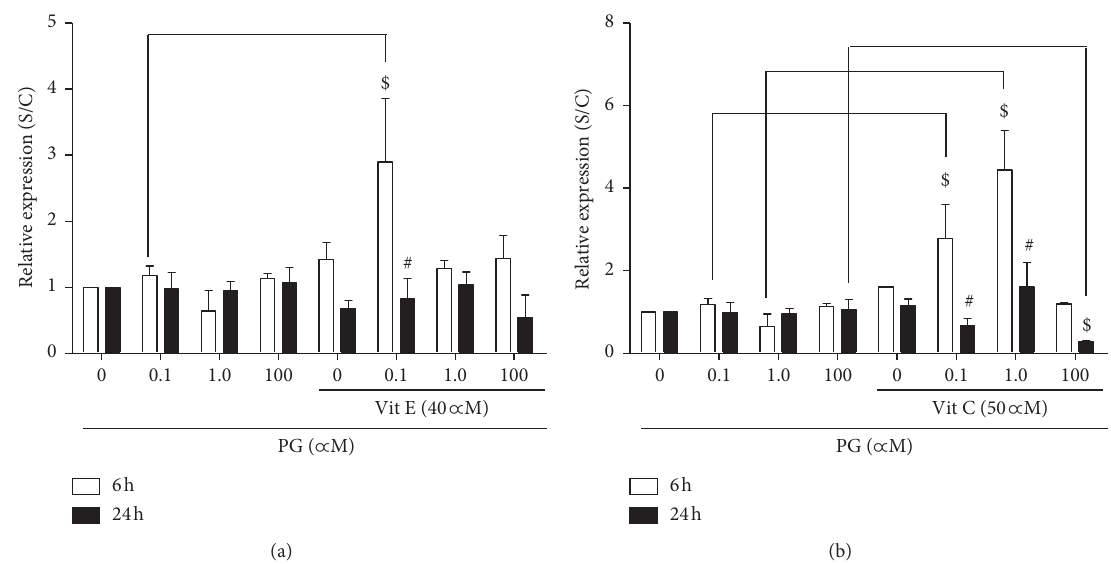
Figure 6: Expression of Prdx4 in progesterone-treated RINm5Fcells, in the presence of antioxidants. After preincubation with 40 μ M vitamin E (a) or 50 μ M vitamin C (b) for 2h, cells were incubated, for 6 or 24 h, with 0.1, 1.0, or 100 μ M progesterone. Data are presented as means ± SEM of three experiments in duplicates. ∗ indicates difference compared to control. # indicates difference between the incubation time points, for the same progesterone concentration. $ indicates difference in comparison to the treatment without antioxidants ( ρ < 0.05). PG: progesterone; Vit E: vitamin E; Vit C: vitamin C.